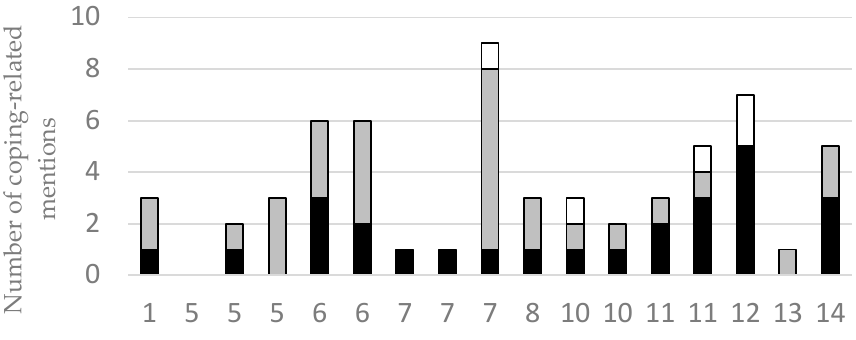
Figure 1. The relationship between the number of mentions of eco-anxiety, eco-grief, and eco-guilt and the various ways of coping in each interview. Note: The horizontal axis shows the data for the seventeen participants, in ascending order based on the number of “psychoterratic” symptoms, which is shown below each bar. The different colors (black, grey, white) of the bars indicate the different types of coping mechanisms. The vertical axis shows the number of the coping mechanisms mentioned by the